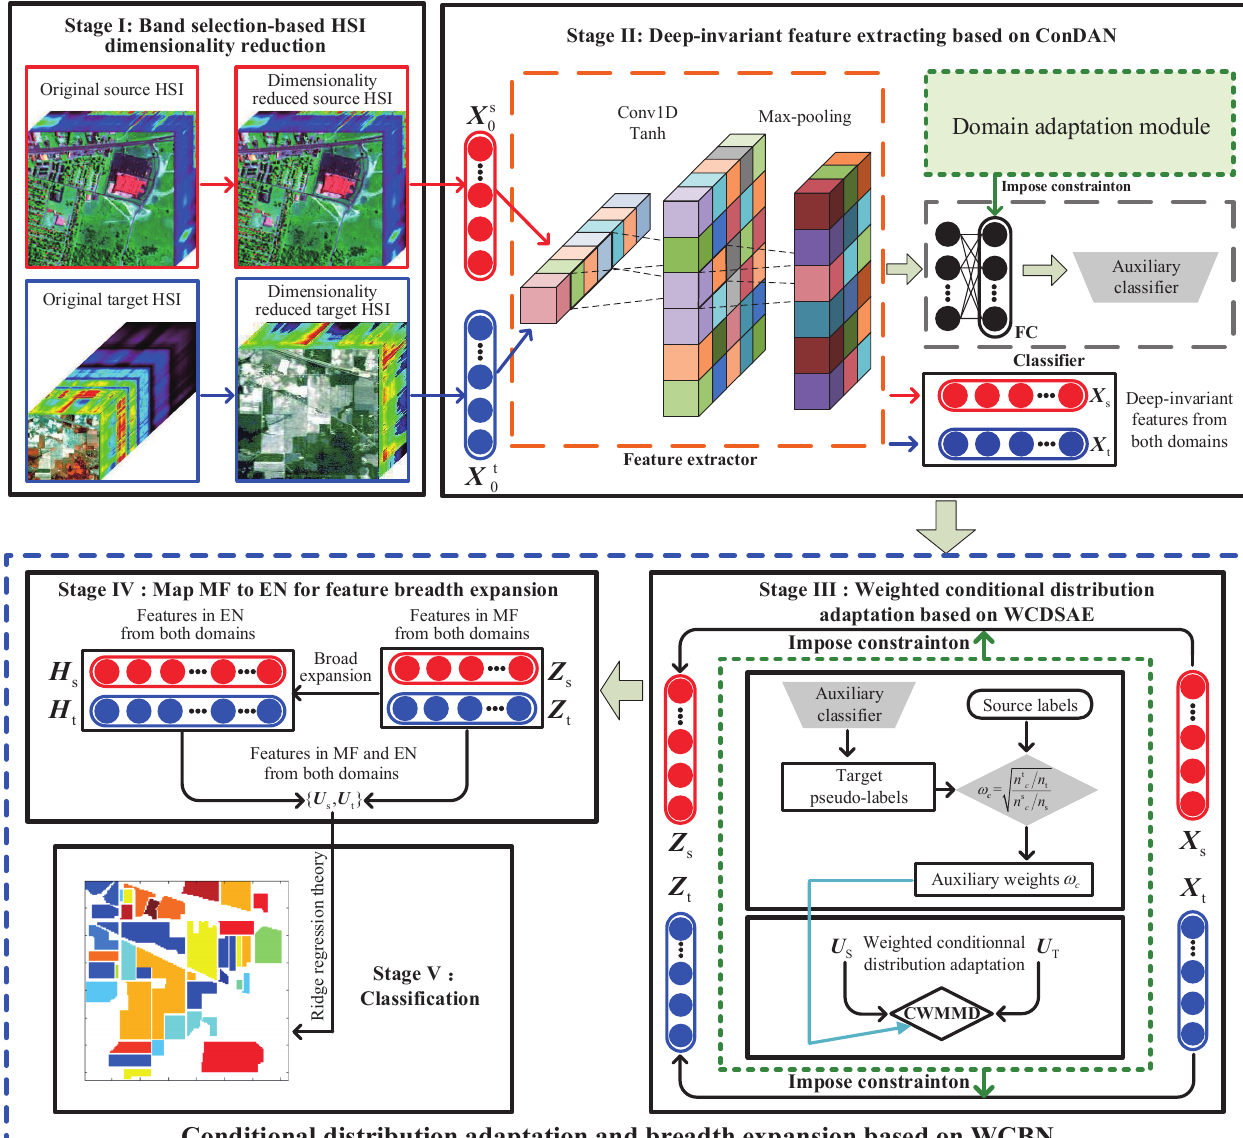
Figure 1. Structure diagram of